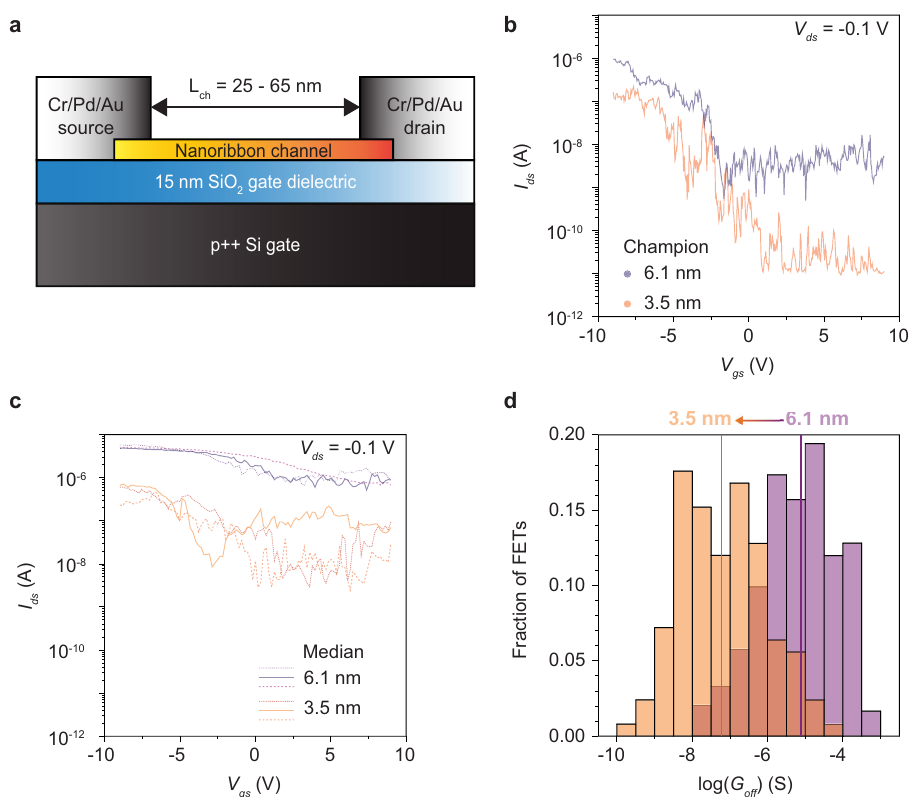
Fig. 5 FET measurements of 6.1 and 3.5 nm wide, PTCDA-derived nanoribbons. a Nanoribbon FET architecture. b and c Source – drain current ( I ds ) versus source – gate bias ( V gs ) at a source – drain bias ( V ds ) of − 0.1 V for one champion ( b ) and three median ( c ) FETs for each nanoribbon width population. d Histograms of off-state conductance ( G off ). The median off-state conductance improves by 2.2 orders of magnitude in the narrower ribbons. Purple and orange data correspond to nanoribbons with average widths of 6.1 and 3.5 nm,